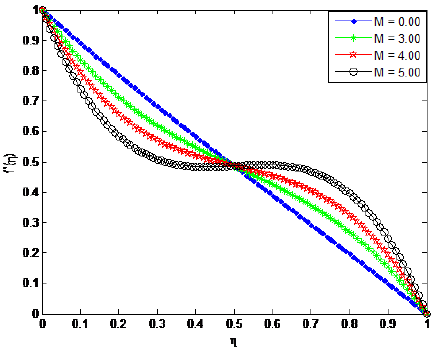
Figure 17. Influence of Hartman number on dimensionless velocity